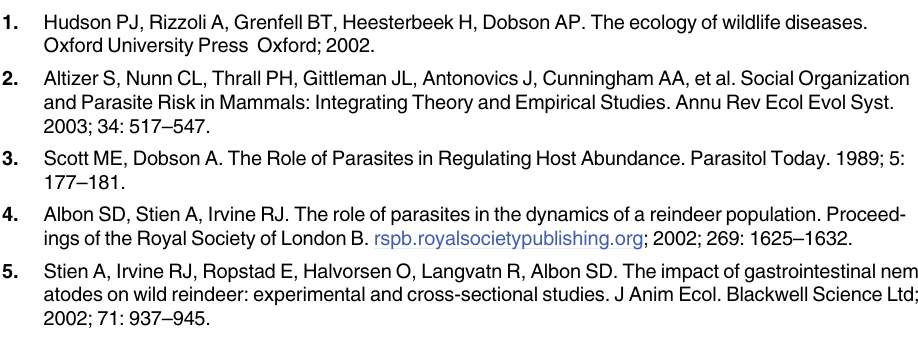
S2 Table. Models to test the association of gastrointestinal parasites and fitness indicators.